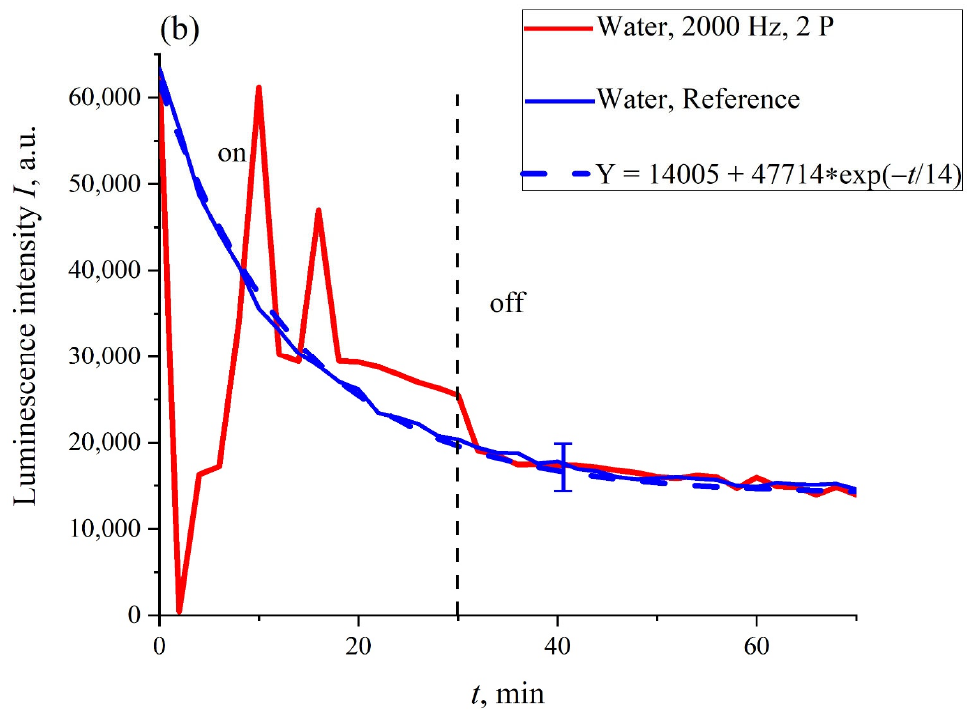
Figure 4. The dependencies of the luminescence intensity I ( t ) on the soaking time in ordinary water upon ultrasonic irradiation with one piezoelectric transducer (panel ( a )), and two transducers (panel ( b )). The vertical dotted line marks the moment when the ultrasound was turned off (30th minute).